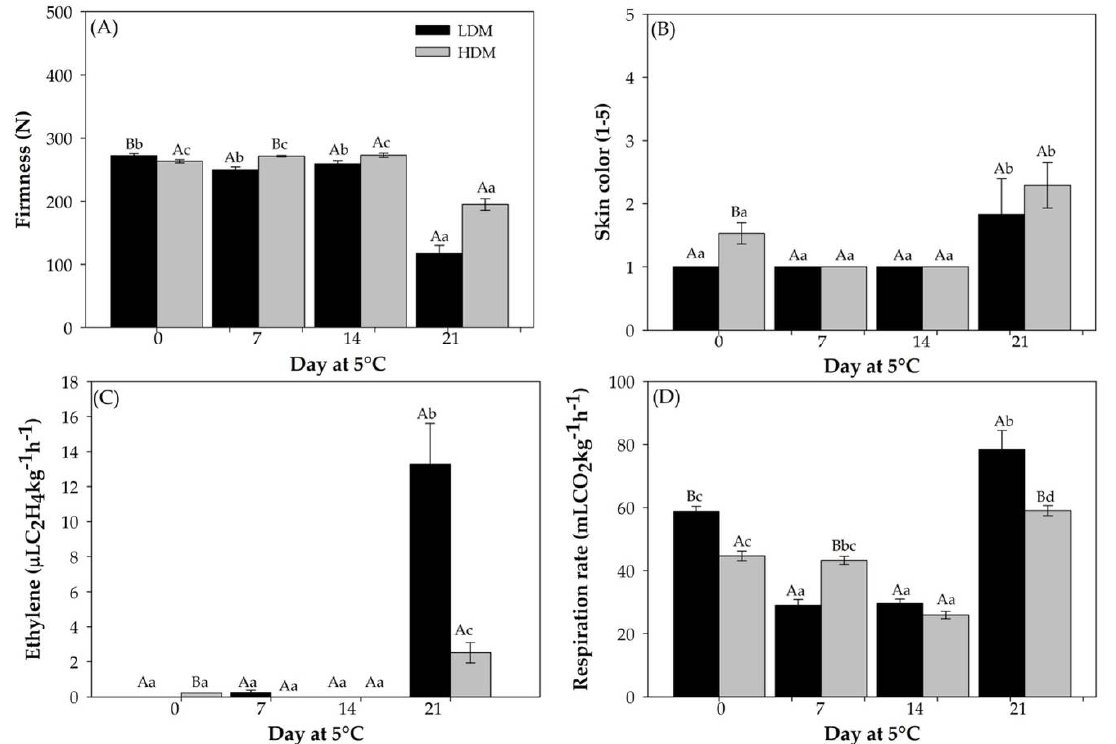
Figure 3. Quality and physiological parameters in “Hass” avocado in the moment of applying 1–MCP. Fruit from LDM and HDM were stored for 0, 7, 14, and >21 d at 5°C in regular air. ( A ) Firmness (N). ( B ) Skin color (range 1–5). ( C ) Ethylene production ( µ L C 2 H 4 kg − 1 h − 1 ). ( D ) Respiration rate (mL CO 2 kg − 1 h − 1 ). Different lower-case and capital letters indicate a significant difference